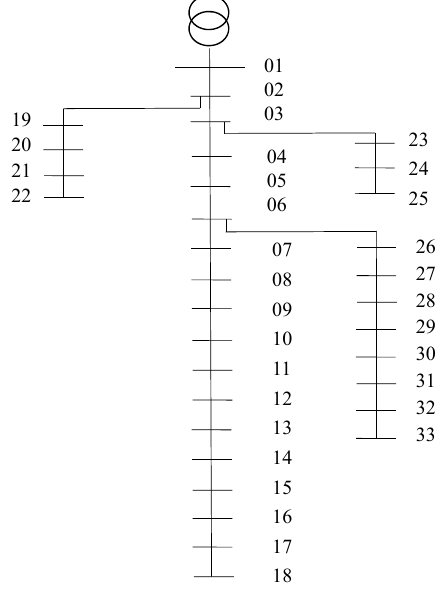
Figure 2. Structure of the IEEE 33-bus radial distribution